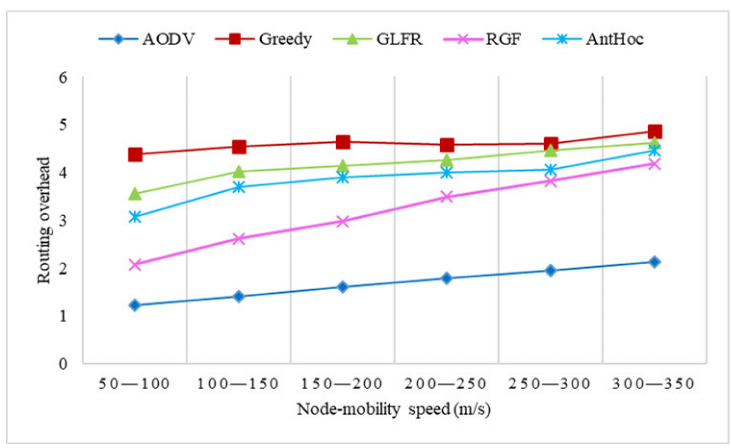
Figure 15. The effect of velocity on average delay.